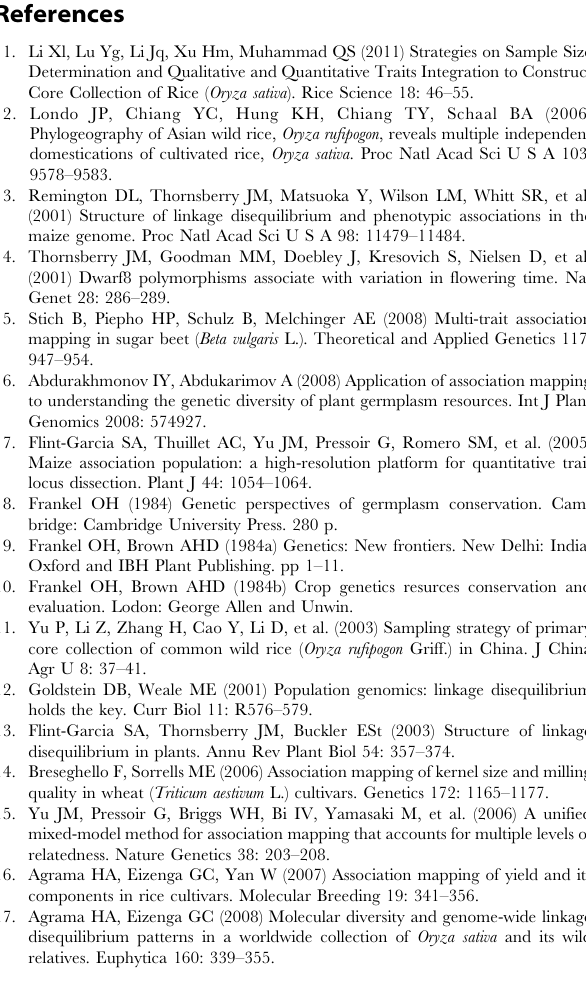
Table S2 Summary statistics of the 274 SSR markers used in this study. Note: Chr No-Chromosome number, AN- number of alleles per locus, GD-Gene diversity, PIC-Polymor- phism information